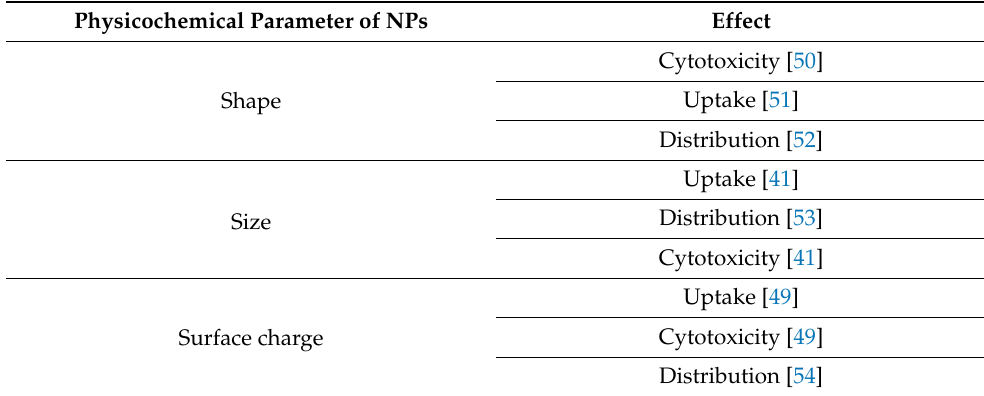
Table 2. Effect of the physicochemical properties of NPs on biological performance. Physicochemical Parameter of